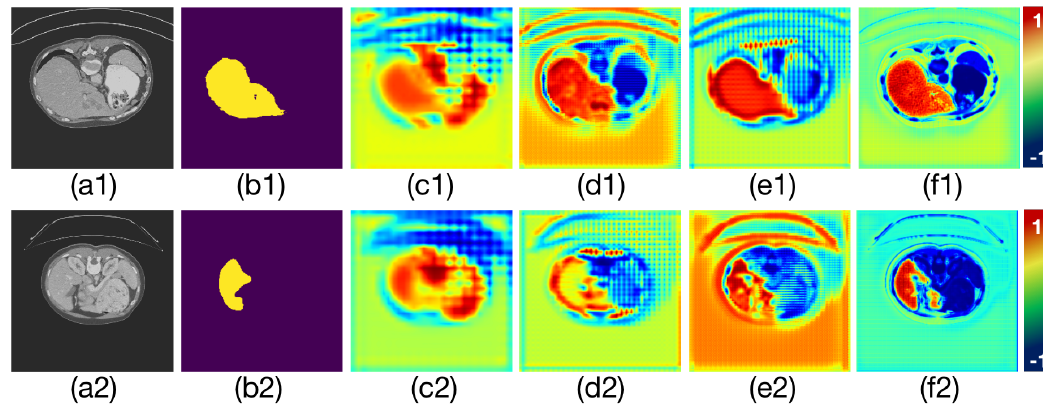
Figure 14. The graph of the attention coefficient α changing with training. The color change in the figures represents the change in the weight of attention learning, where red represents enhancement and blue represents inhibition. ( a1 – f1 ) is the first group of changes. ( a2 – f2 ) is the second group of changes. ( a1 , a2 ) are the input CT images. ( b1 , b2 ) are the ground truth of liver, respectively. ( c1 – f1 ) and Figure ( c2 – f2 ) are two groups of the attention coefficients α in different training phases.